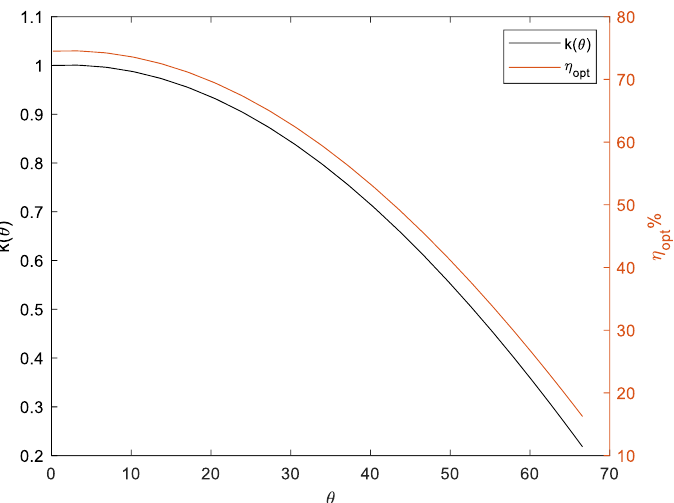
Figure 12. Incident angle modifier and optical efficiency for the different angular values.